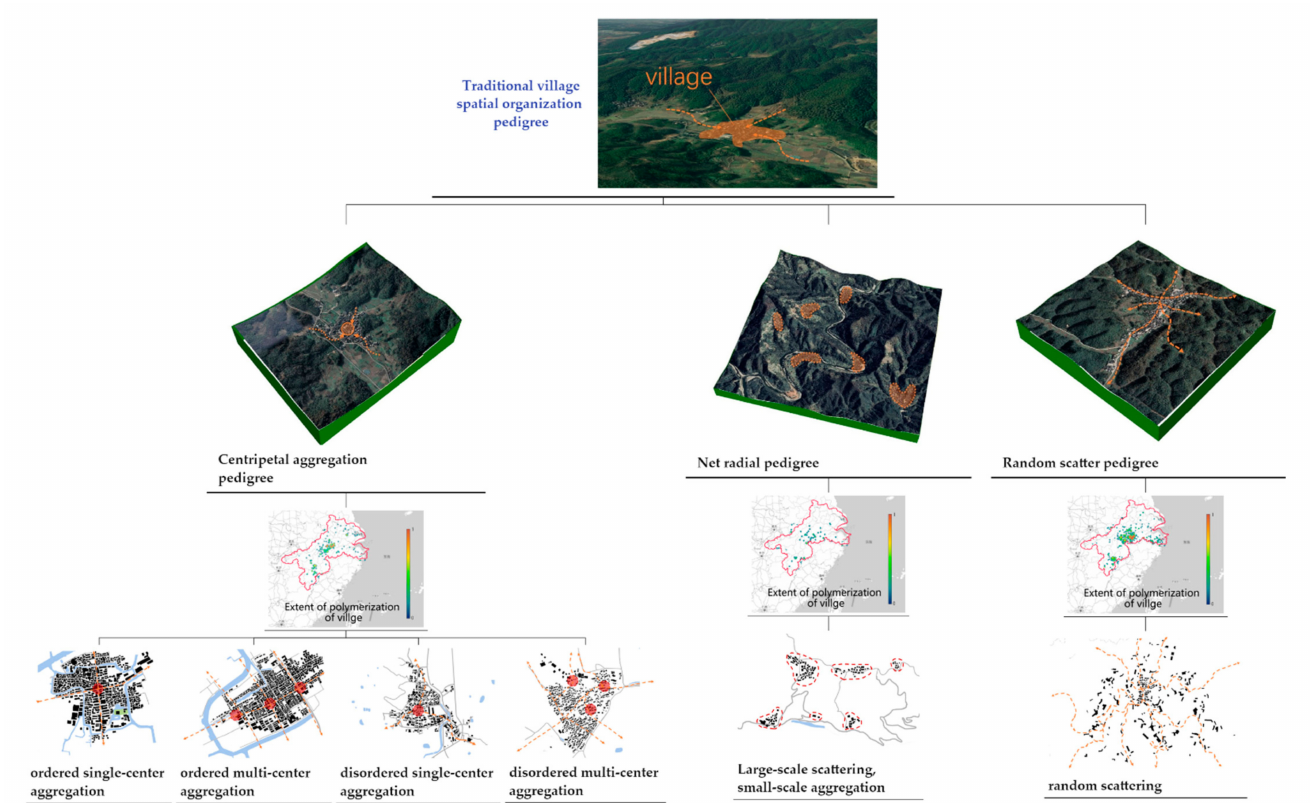
Figure 8. Traditional village spatial organization pedigree structure: edited by